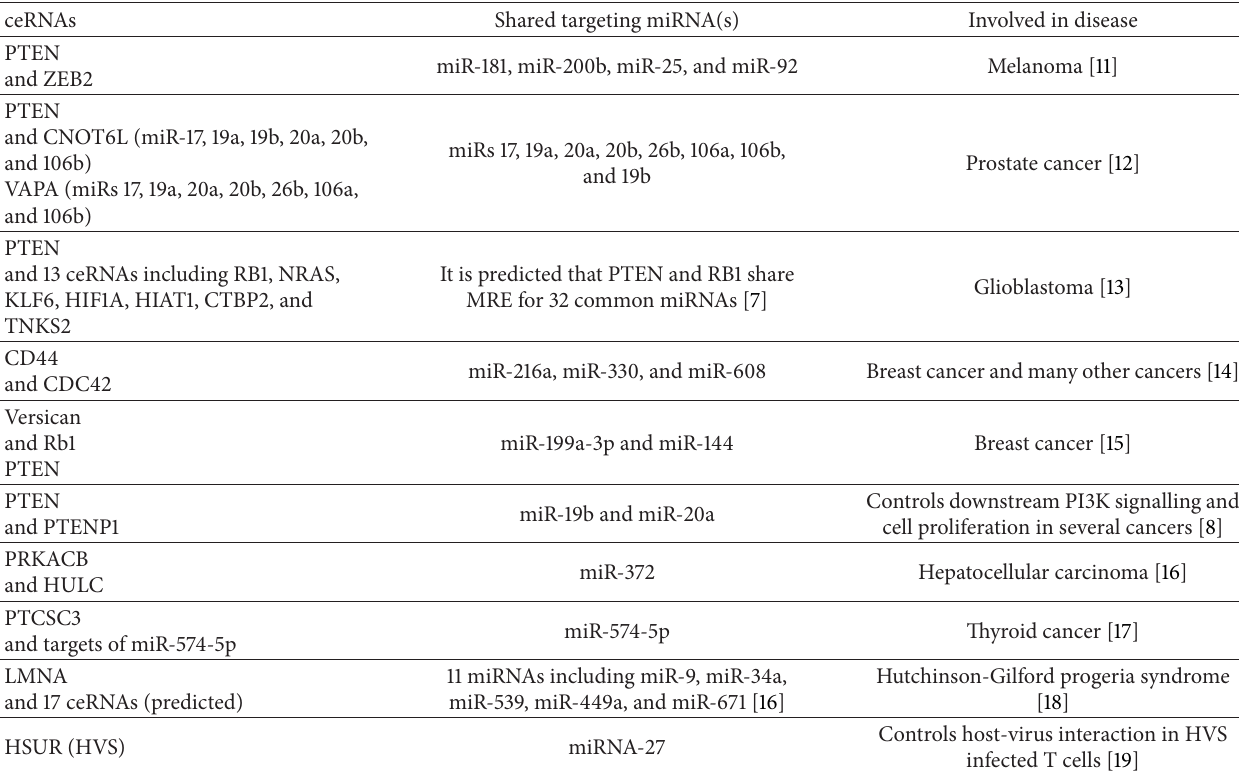
Table 1: A list of ceRNAs reported to be associated with